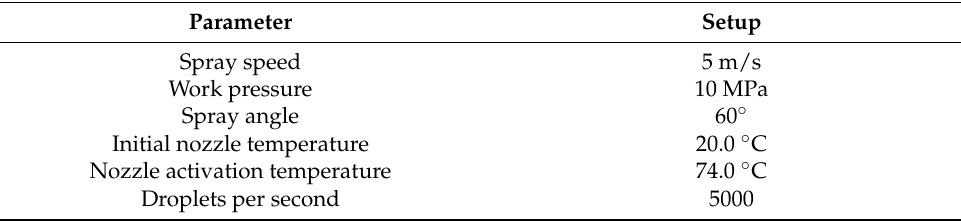
Table 3. Water-mist nozzle parameter